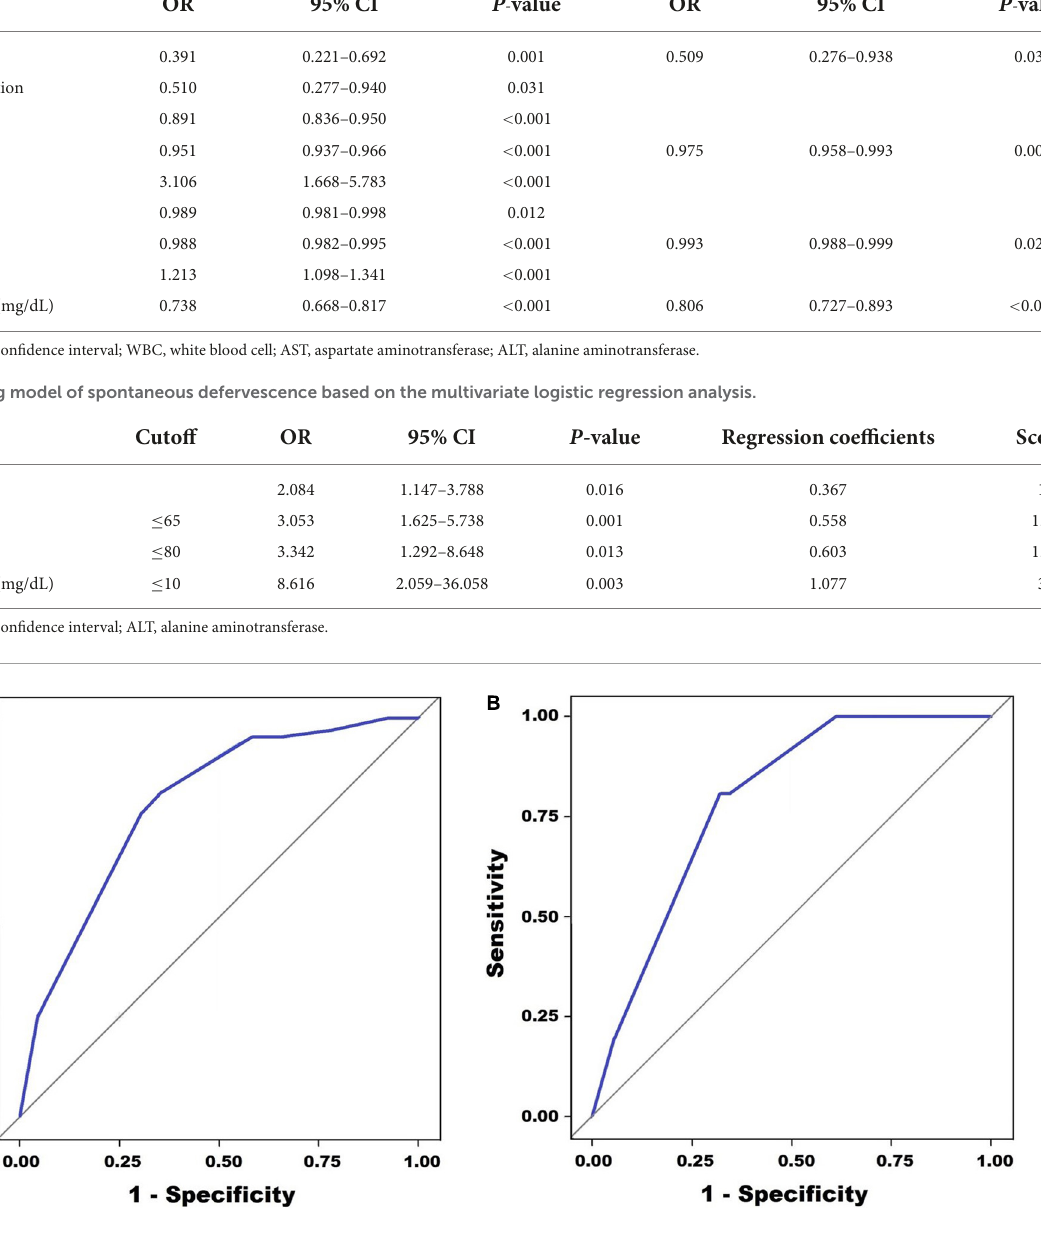
FIGURE2 Receiver operating characteristic (ROC) curve analysis for the prediction of spontaneous defervescence. Panel (A) shows the multivariate regression model in the training set (AUC = 0.784, 0.737–0.834) and panel (B) shows multivariate regression model in the validation set (AUC = 0.787,